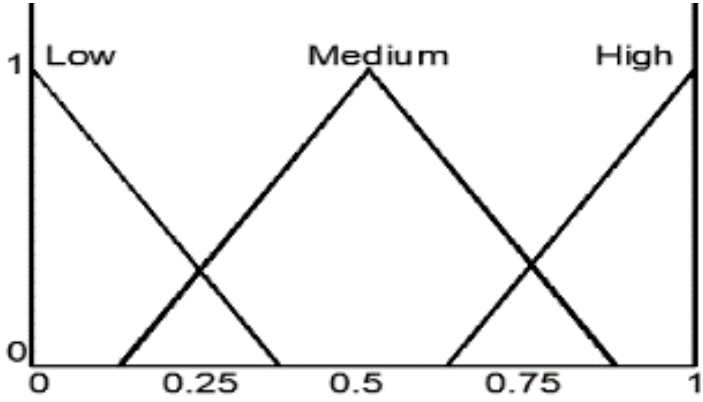
Figure 6. Membership functions of input .